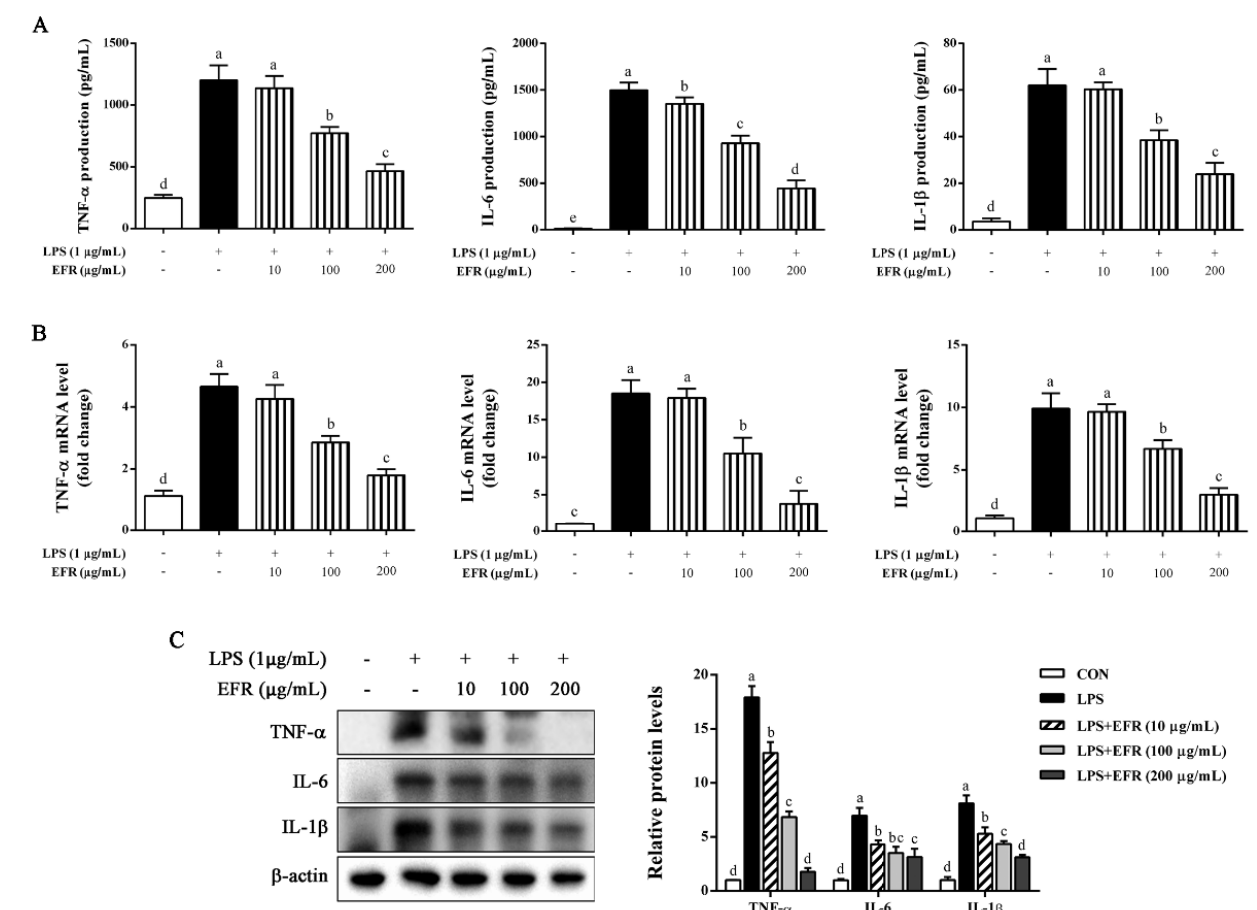
Figure 2. Effect of EFR on LPS-induced TNF- α , IL-6, and IL-1 β production and expression in RAW 264.7 macrophages. RAW 264.7 macrophages were pretreated with EFR (10, 100, and 200 μg/mL) for 2 h and then stimulated with or without LPS (1 µ g/mL) for 24 h. The secretion ( A ), mRNA ( B ), and intracellular protein ( C ) levels of TNF- α , IL-6, and IL-1 β were determined by ELISA, qPCR, and Western blot analysis, respectively. IL-1 β refers to full-length pro-IL-1 β . Results are shown as the mean ± SD of three independent experiments. The different letters represent the statistical differences at p < 0. 05 among the groups by Duncan’s multiple range test.